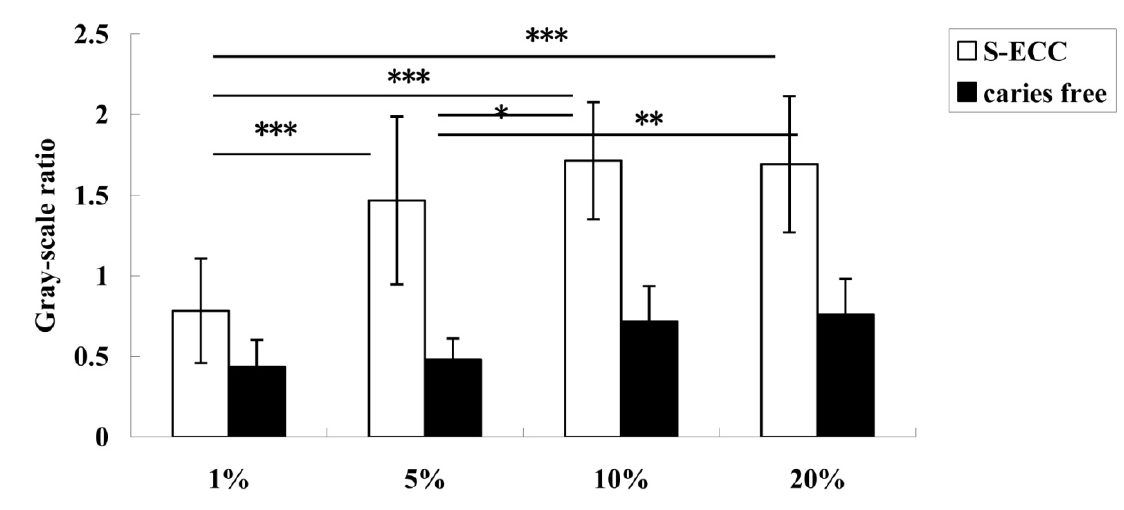
Figure 4. The expression of gtfB in S. mutans from children with ECC and caries-free children when sucrose concentration was 1%, 5%, 10%, and 20%. The expression level of gtfB increased significantly when the sucrose concentration was 1% to 10%, and the expression in the 1% and 5% groups was significantly lower than in the 10% and 20% groups. * Denotes statistical significance ( p < 0.05), ** Denotes statistical significance ( p < 0.01), and *** Denotes statistical significance ( p <